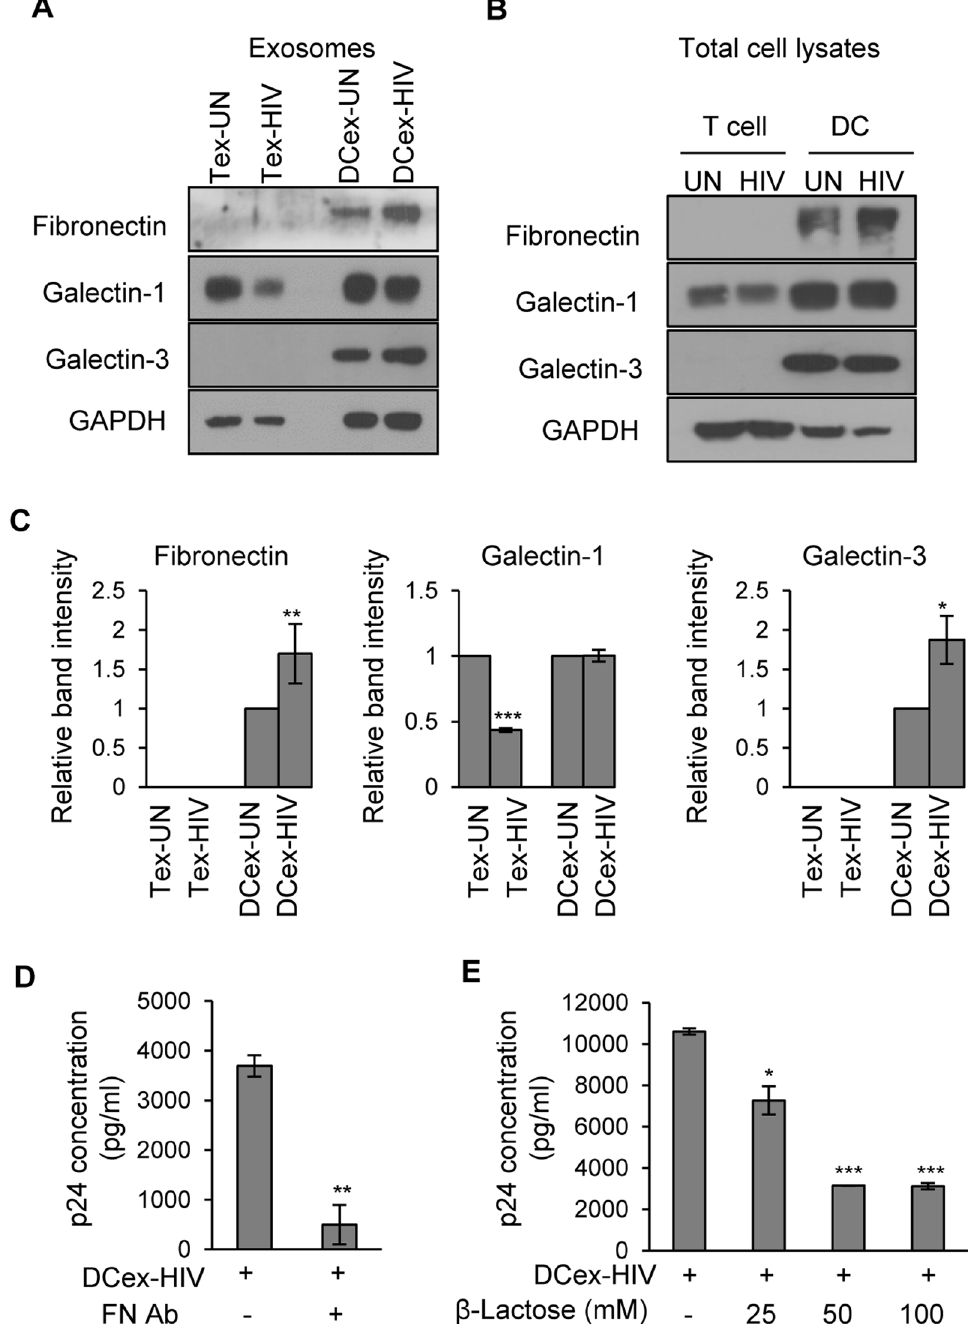
Figure 4. Exosomes derived from HIV-1 infected (DCex-HIV) DCs infected T cells via Fibronectin and Galectin. ( A and B ) Representative Western blot images showing the expression of fibronectin, galectin-1 and galectin-3 in lysates of exosomes derived from uninfected (Tex-UN) or HIV-1 infected (Tex-HIV) T cells, and uninfected (DCex-UN) or HIV-1 infected (DCex-HIV) DCs (A) and total cell lysates ( B ). GAPDH used as a loading control. Full-length blots are presented in Supplementary Figure S3. ( C ) Quantitative analysis of Western blot images of fibronectin, galectin-1 and galectin-3 of ( A , exosomes). The band intensity of each lane was determined by Image J software and pixel density was calculated by normalizing to exosomes from uninfected cells. ( * p ≤ 0.05, ** p ≤ 0.01, *** p ≤ 0.001, p-values for Fibronectin – 0.00764, Galectin-1 – 0.0000003, Galectin-3–0.03248). ( D ) HIV-1 p24 titer in supernatants of T cells incubated with DCex-HIV in presence or absence of anti-fibronectin antibody for 7 days ( ** p ≤ 0.01, p-value – 0.009764). ( E ) HIV-1 p24 titer in supernatants of T cells incubated with DCex-HIV in presence of various concentrations (0–100 mM) of β -lactose for 7 days. The data represents mean of triplicates ± SE from three independent experiments ( * p ≤ 0.05, *** p ≤ 0.001, p-values for 25 mM – 0.02144, 50 mM – 0.000201, 100 mM –